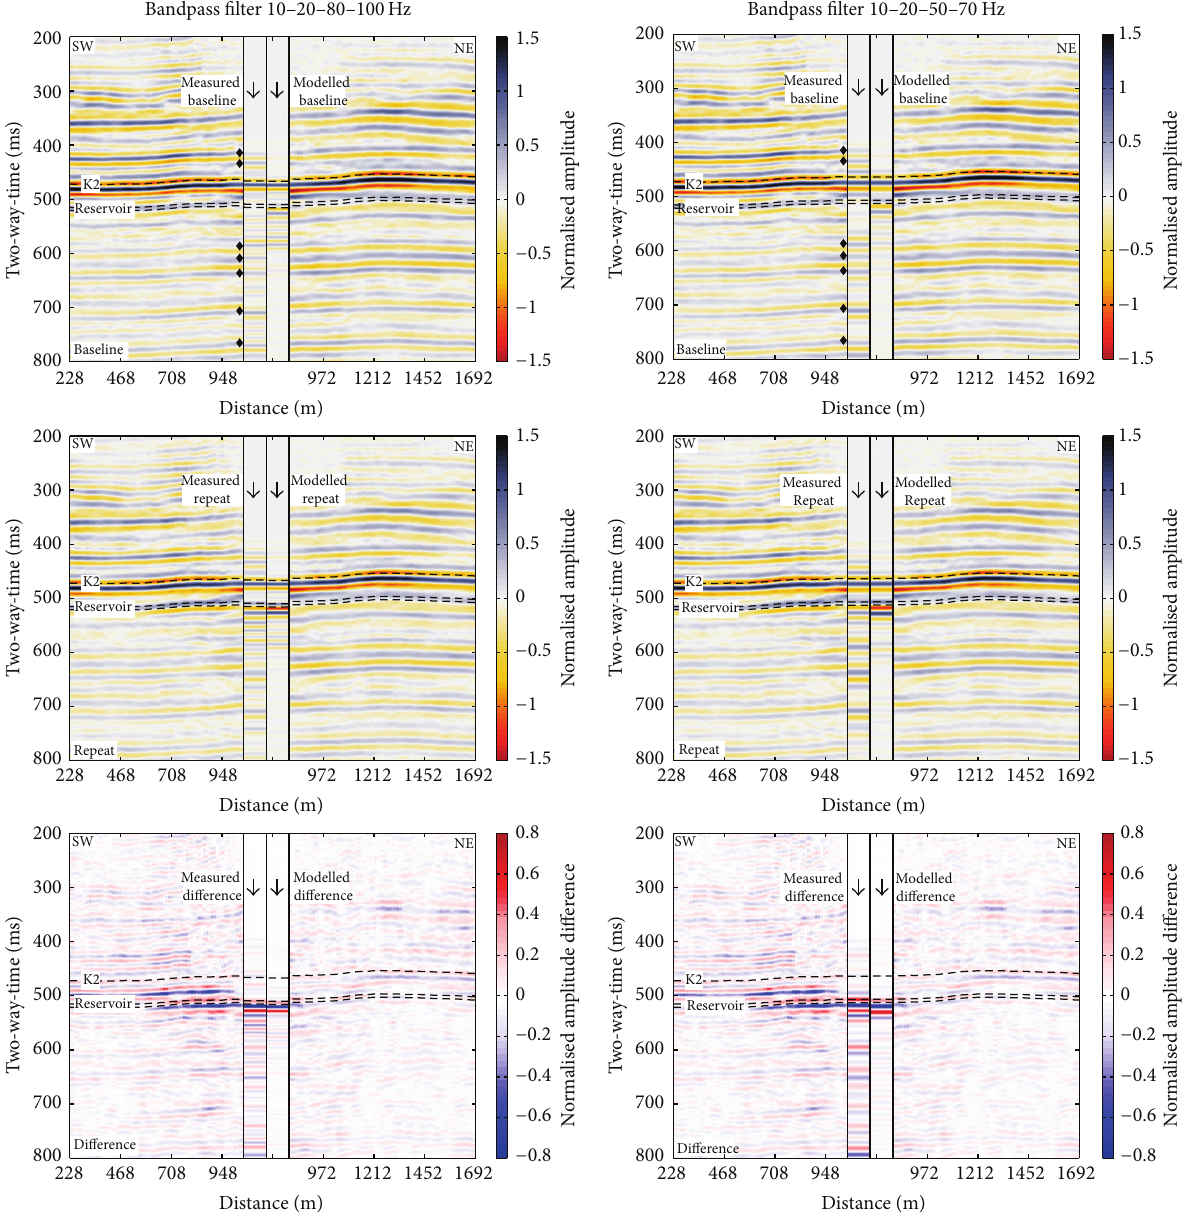
Figure 8: Comparison of zero-offset VSP with 3D surface seismic. A detail of the 3D surface seismic inline 1172, which crosses the observation well Ktzi202 (Figure 2) is shown. The traces of the measured and modelled VSP are plotted side by side and inserted at the intersection of inline 1172 with the well. From top to bottom baseline, repeat and difference (repeat minus baseline) of 3D surface seismic and VSP are shown. Consistent phases of 3D surface seismic and zero-offset VSP are marked with diamonds. The VSP data of the left column is bandpass filtered The black lines mark the positions of the K2 (upper line), the top, and the bottom of the reservoir (middle and bottom